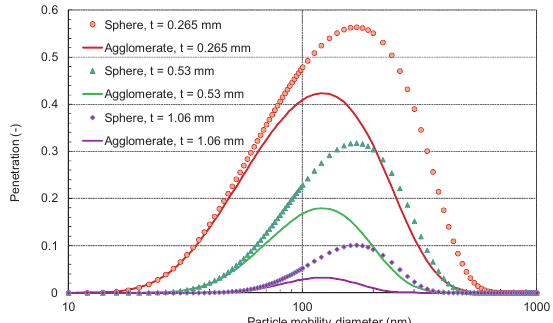
Fig. 9 Penetration values for spherical and agglomer- ated nanoparticles from model calculations for filter thickness values of 0.265, 0.53 and 1.06 mm.